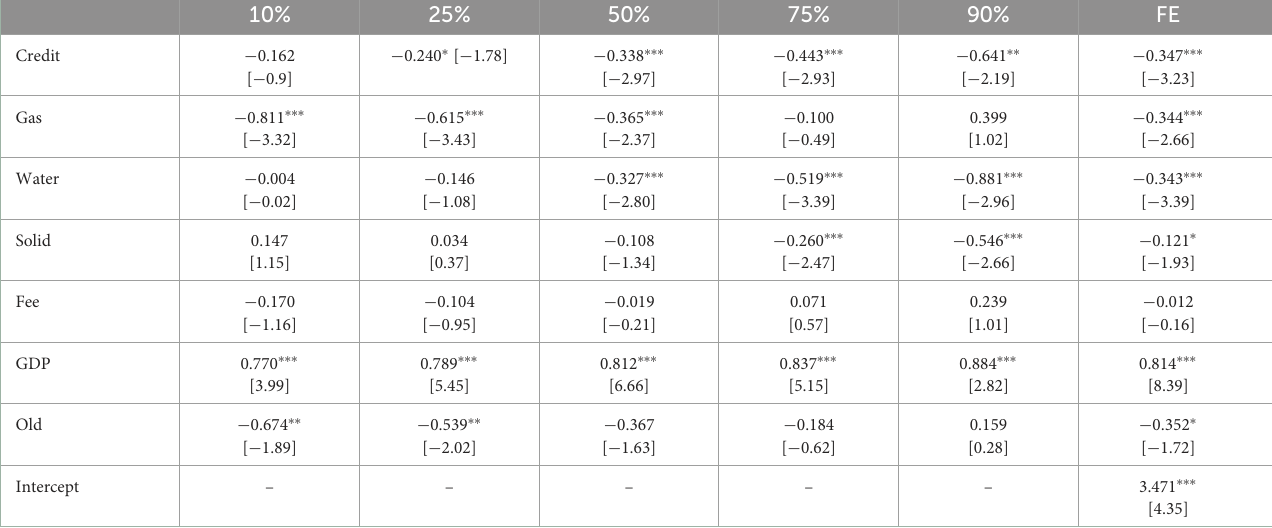
TABLE 2 Quantile regression results of green credit on social health